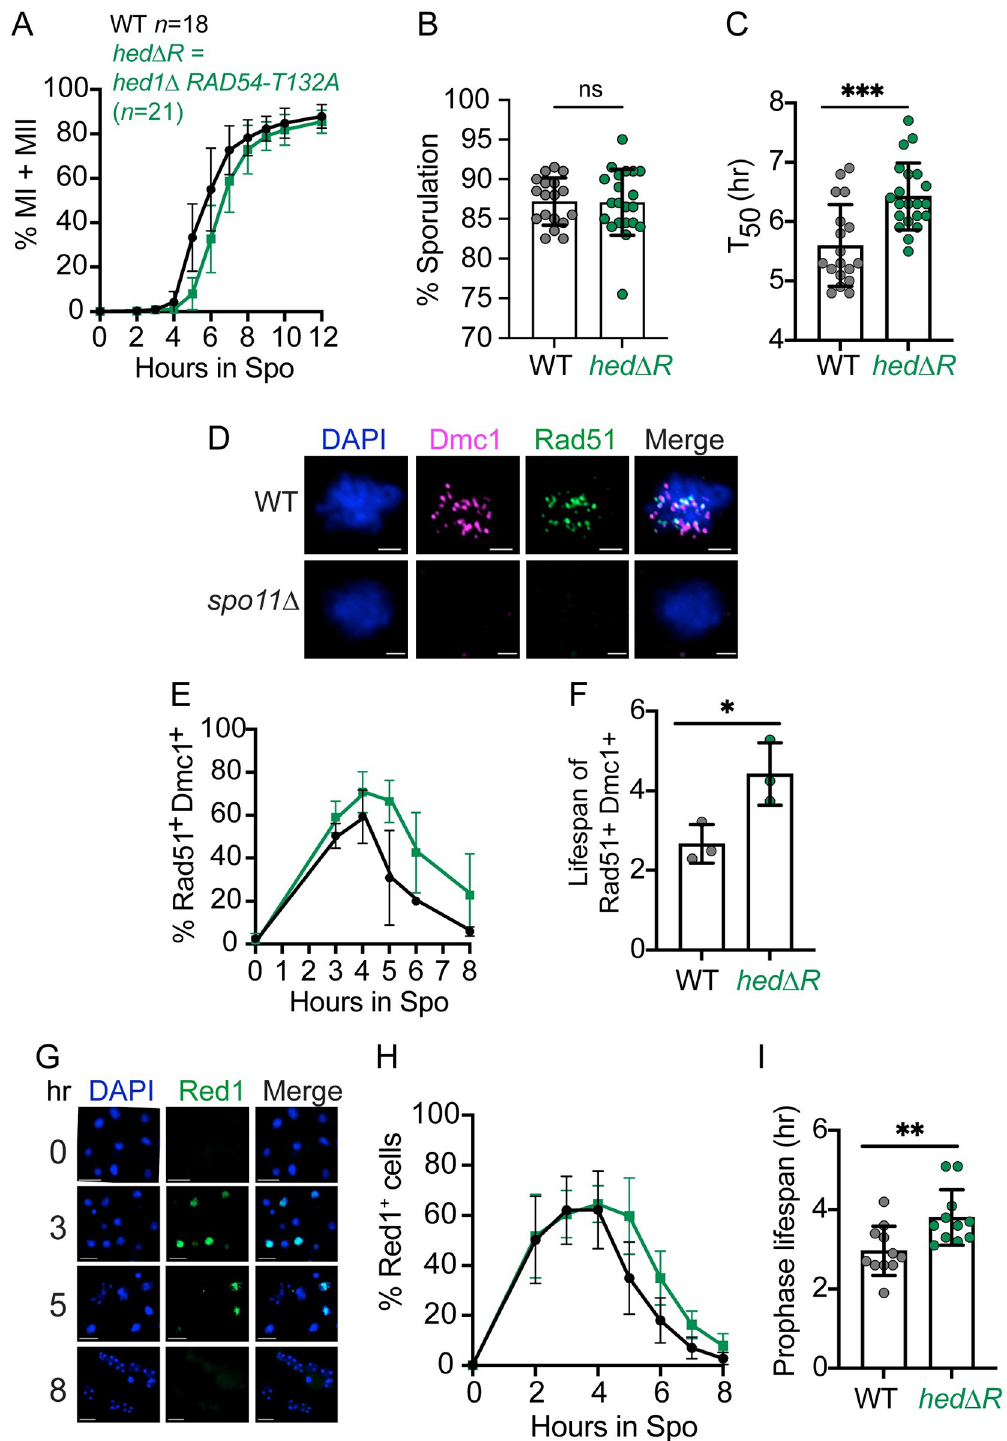
Fig 1. Rad51 activation during Phase 1 causes a delay in meiotic progression, DSB disappearance and prophase I exit. (A) Meiotic progression. WT (NH716 or NH2598 RCEN) ( n = 18) and hed Δ R (NH2528 or NH2616 RCEN) ( n = 21) diploids were transferred to Spo medium. At the indicated timepoints cells were fixed, stained with 4 0 ,6-diamidino-2-phenylindole (DAPI) and examined by fluorescent microscopy for the presence of binucleate (MI) or tetranucleate (MII) cells. The average values from different timecourses were plotted for each time point. At least 200 cells were counted for each timepoint. (B)